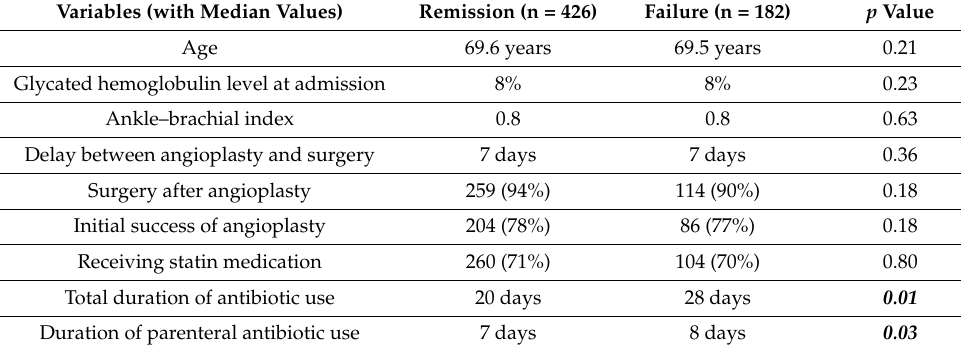
Variables (with Median